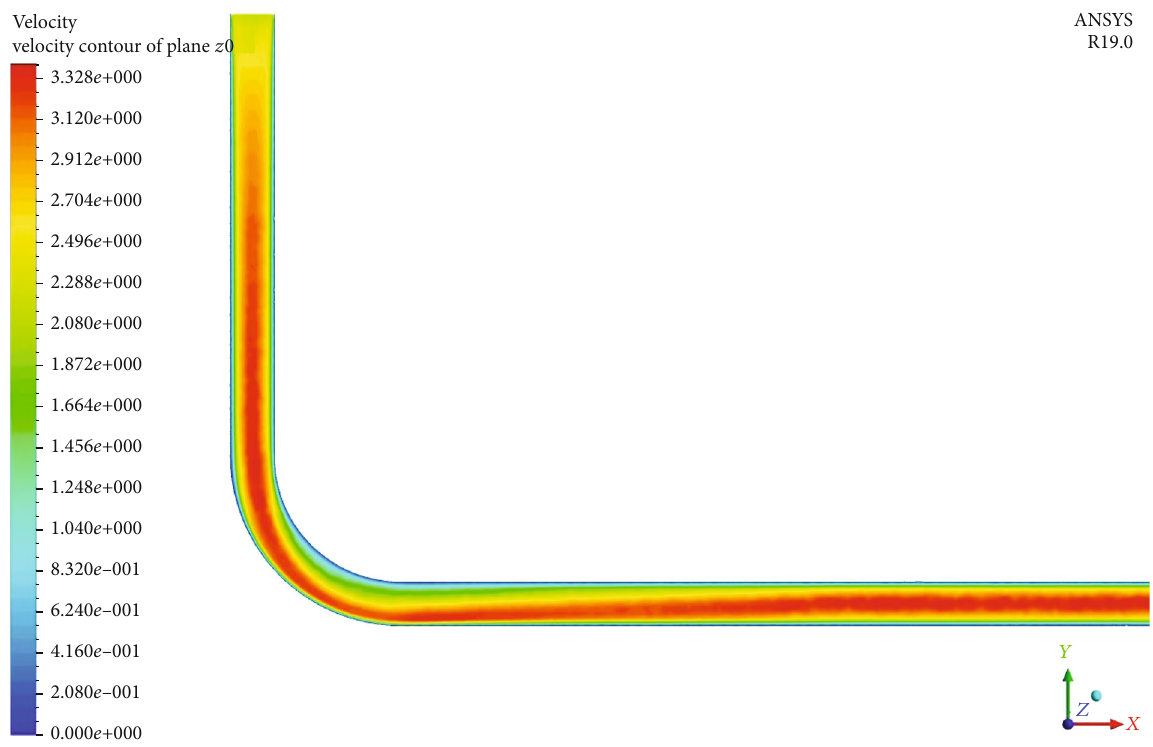
Figure 6: Velocity contour of the observation plane Z = 0m .